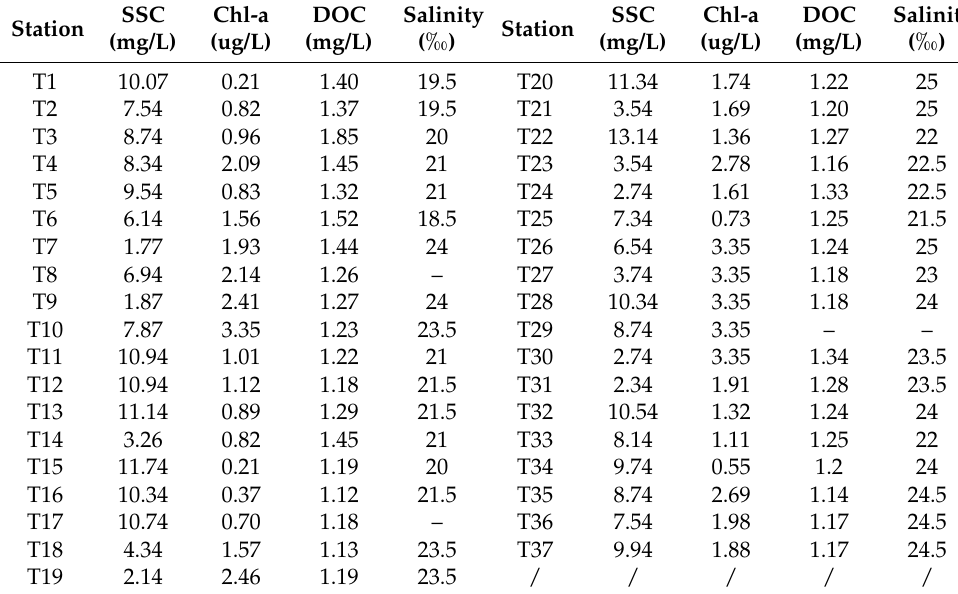
Table 2. Measured results of the main parameters in the study area.